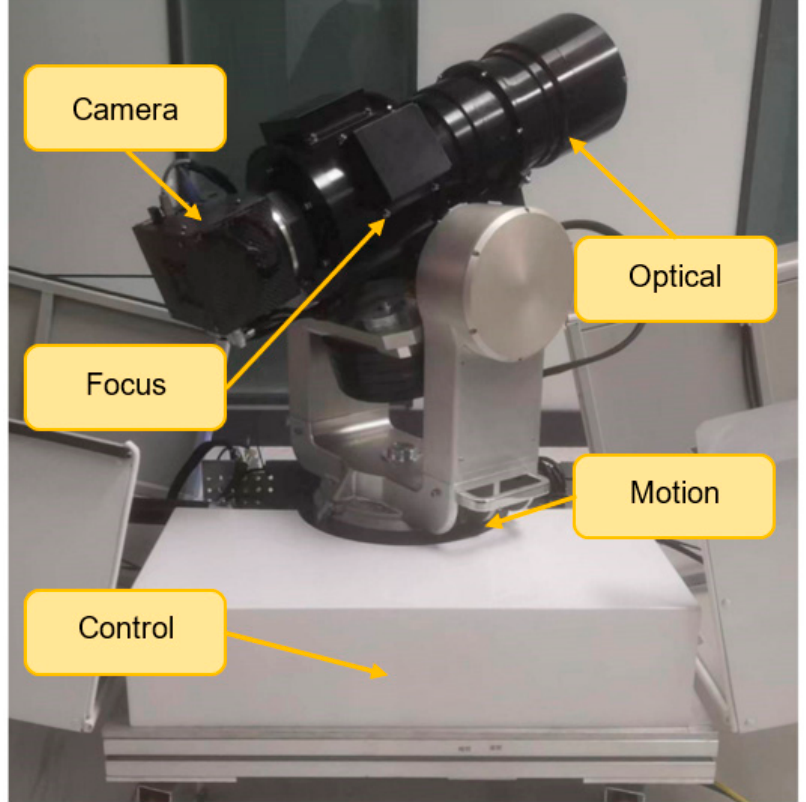
Figure 2. The structural overview of the image acquisition